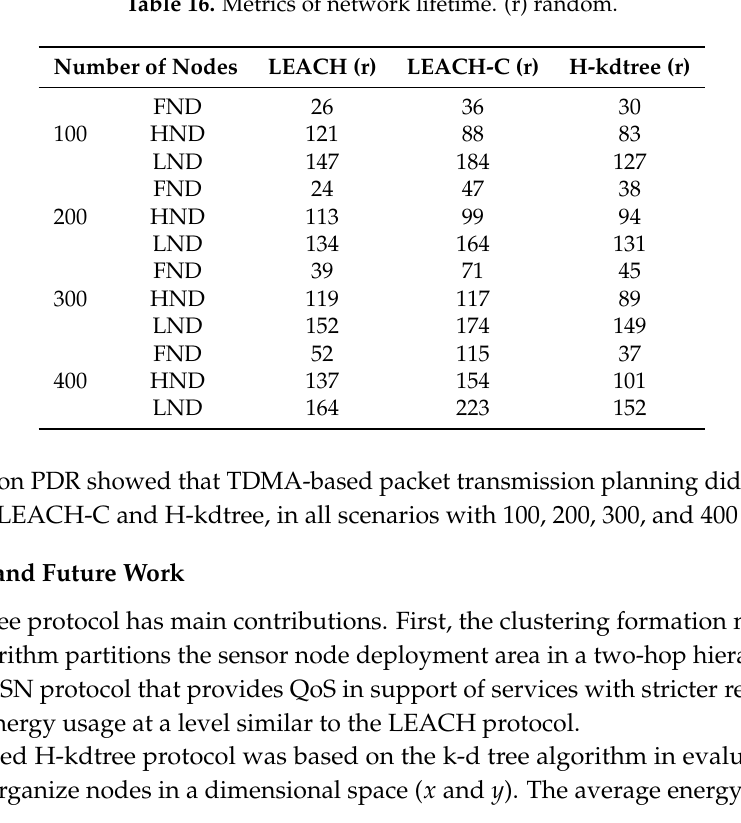
Table 16. Metrics of network lifetime. (r)